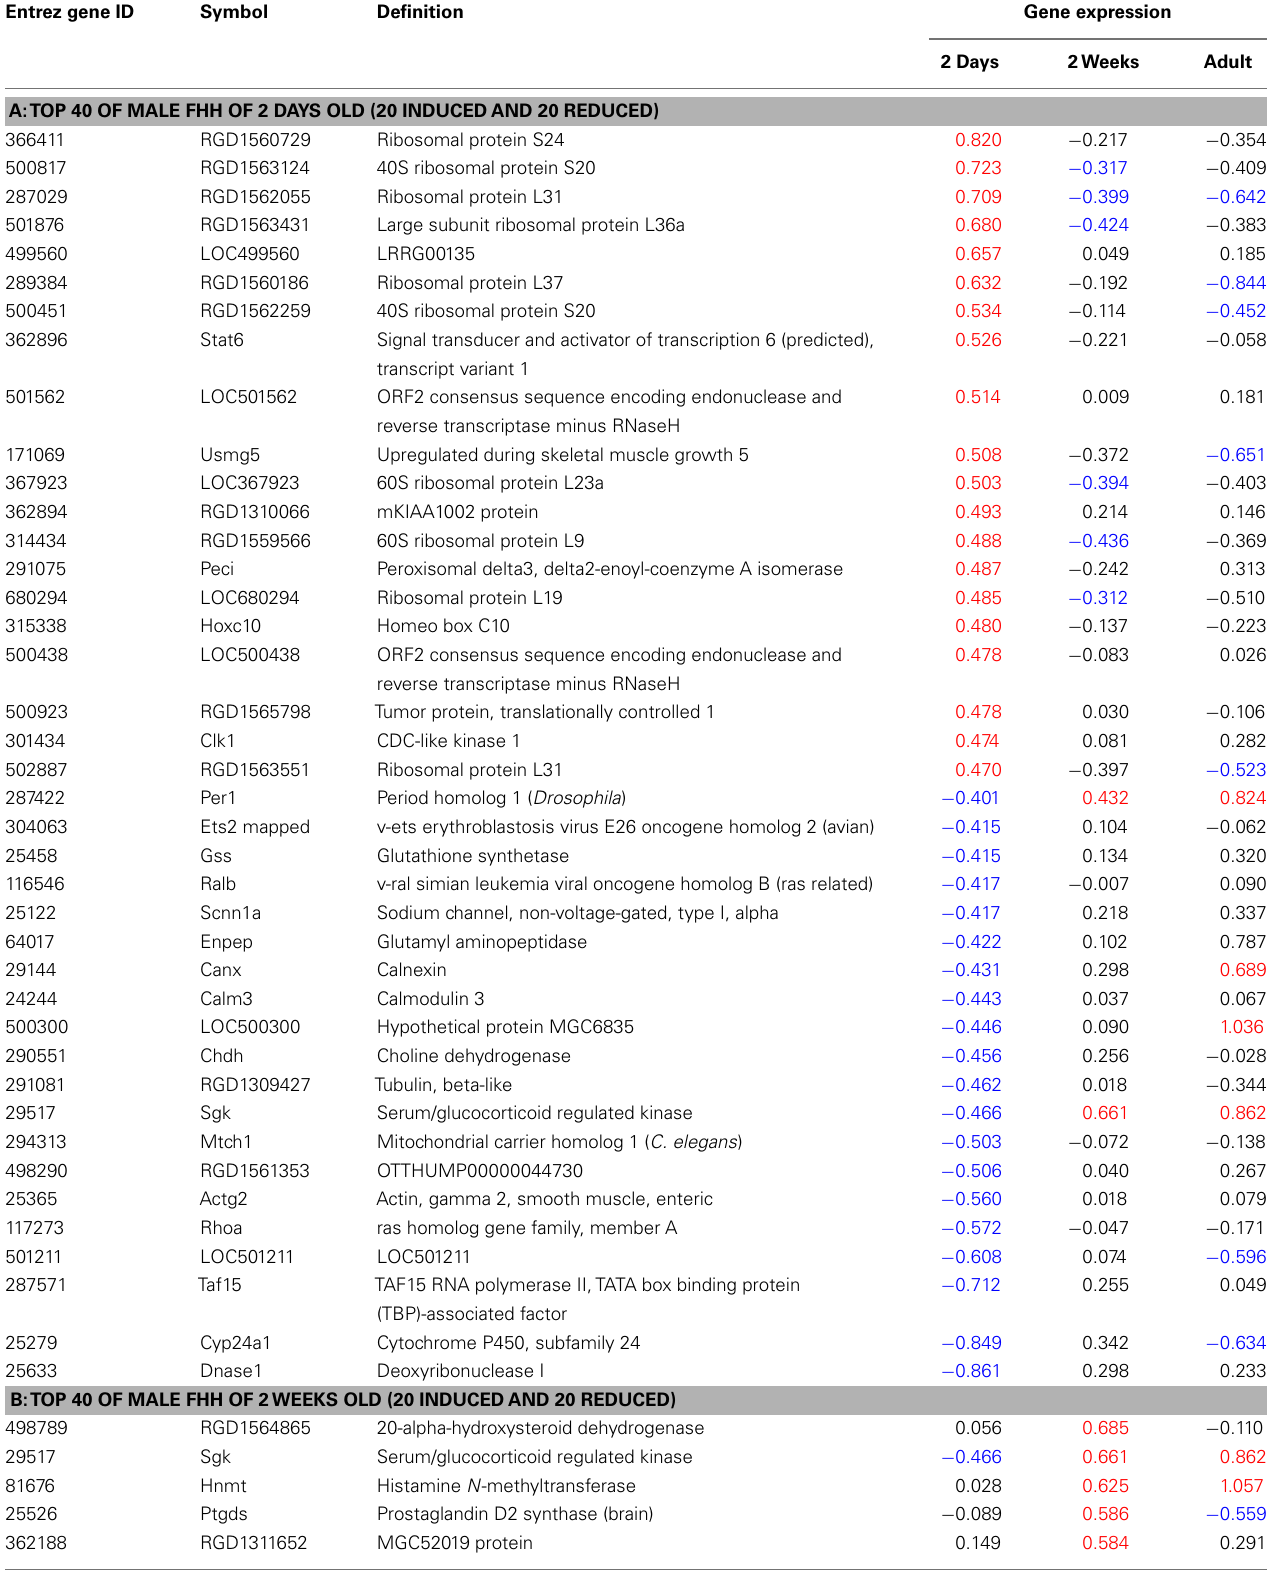
2 Days 2Weeks Adult